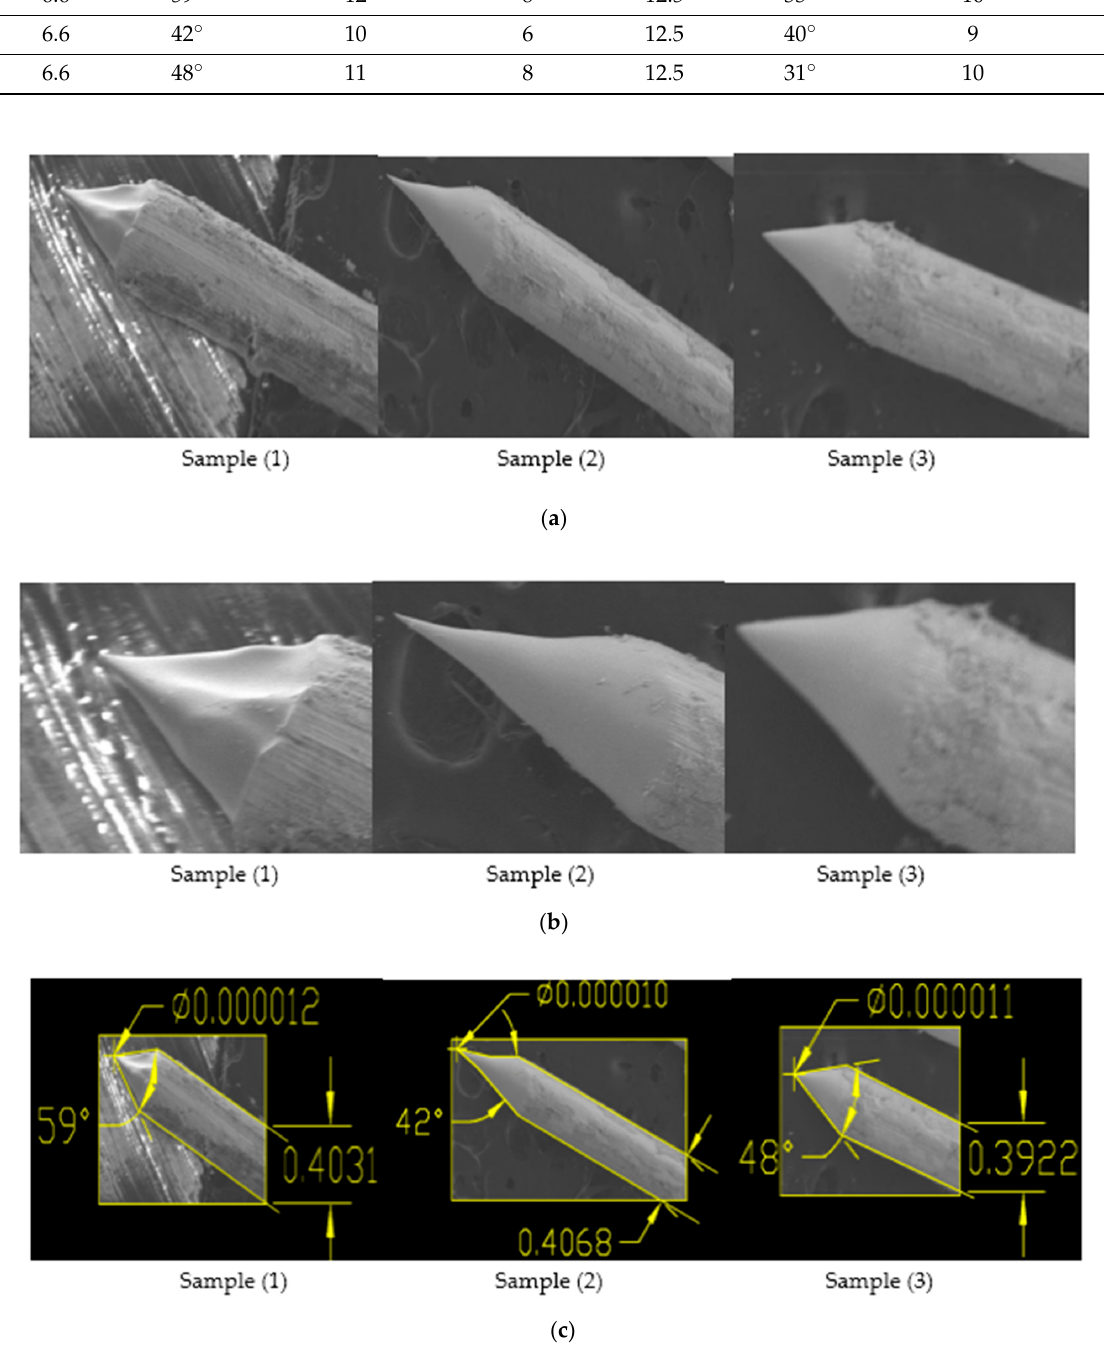
Figure 8. ( a ) SEM Images showing Sample 1 having applied voltage of 6.6 V in 2 M NaOH solution; ( b ) Zoomed-in-View of Sample 1, 2 and 3; ( c ) SEM Images of 0.4 mm tungsten tips showing cone angle and tip diameter measured using AutoCAD Software.